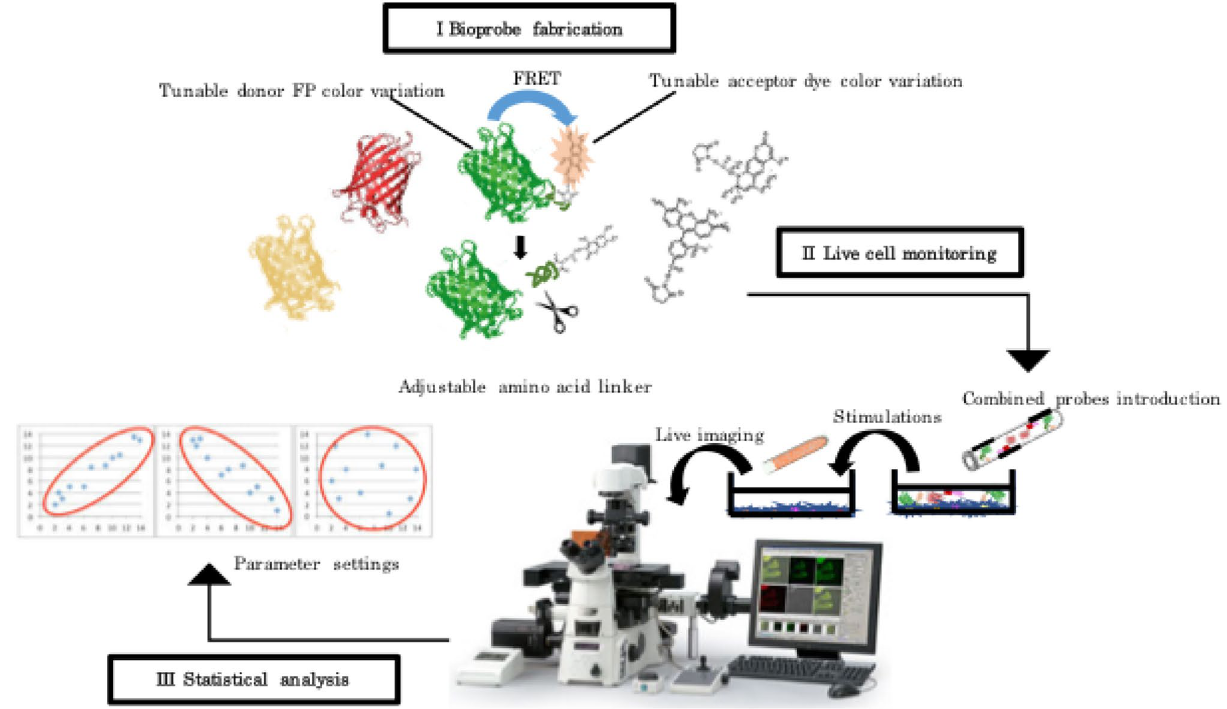
Figure 1. Custom-made fluorescence imaging system consisting of 3 parts: (I) Bioprobe fabrication characterised by tunable components. (II) Live imaging characterised by equipment adjustability and simple approaches. (III) Statistical analysis characterised by flexible parameter settings.